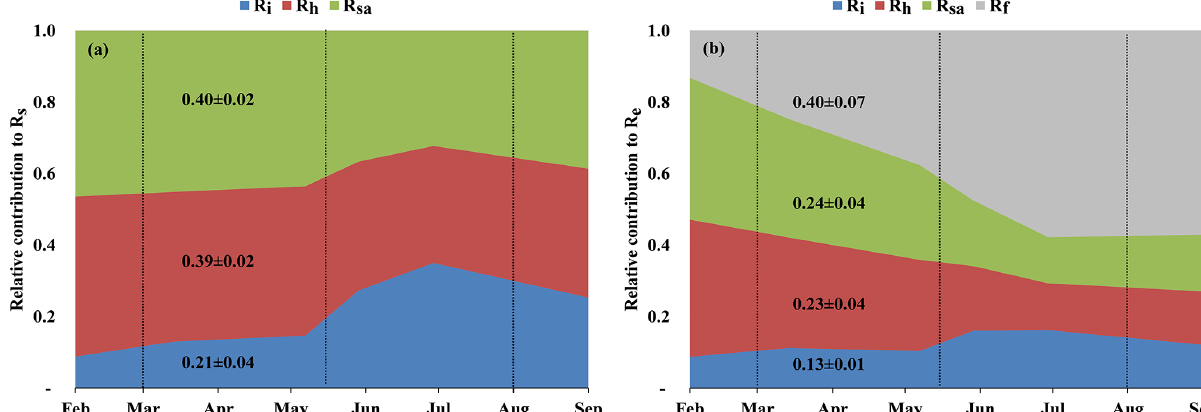
Figure 3. (a) Seasonal variations in the relative contribution of soil autotrophic ( R sa ), heterotrophic ( R h ), and abiotic ( R i ) components to R s , and (b) seasonal variations in the relative contribution of soil autotrophic ( R sa ), heterotrophic ( R h ), abiotic ( R i ), and foliage and stem respiration ( R f is obtained from R e − R s ) components to ecosystem respiration ( R e ) during eight campaigns (January–September) in 2016. The contributions were estimated with linear mixing models using δ 13 C and (cid:49) 14 C of soil respiration ( R s ) and a soil CO 2 profile method at 0 to 120cm soil depth. Vertical dotted lines indicate the winter, spring, summer, and fall seasons. These results confirmed earlier estimates of Grünzweig et al. (2009) and Maseyk et al. (2008a).